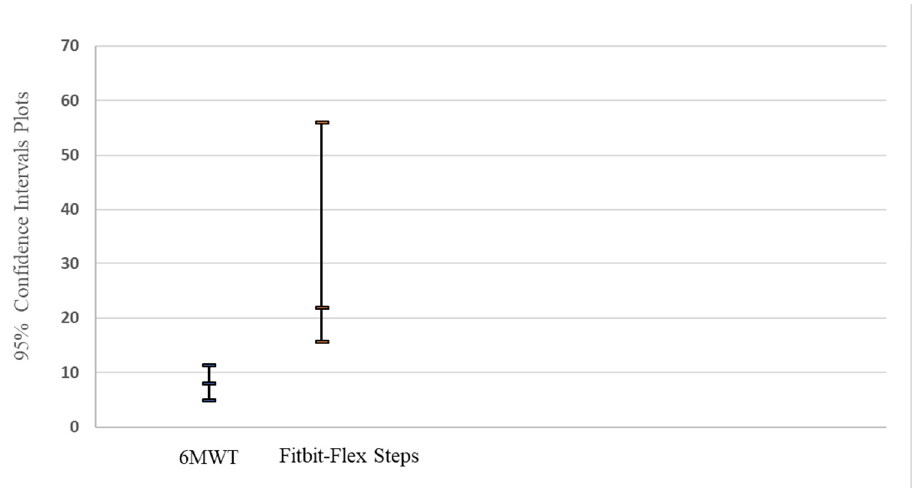
Figure 1. A 95% CI plot of the relative difference for 6MWT and Fitbit-Flex at entry of CR to com-